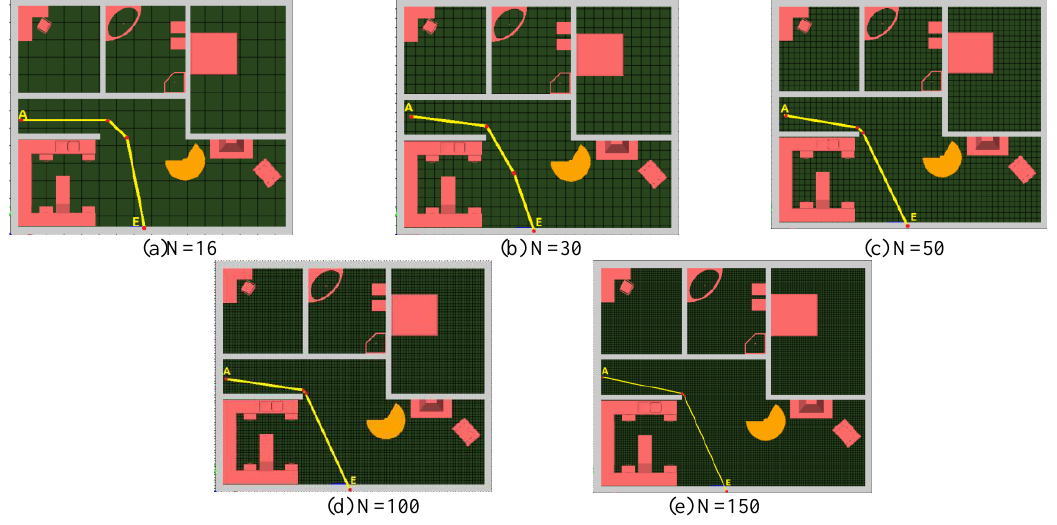
Figure 6. The shortest path for different grid count and